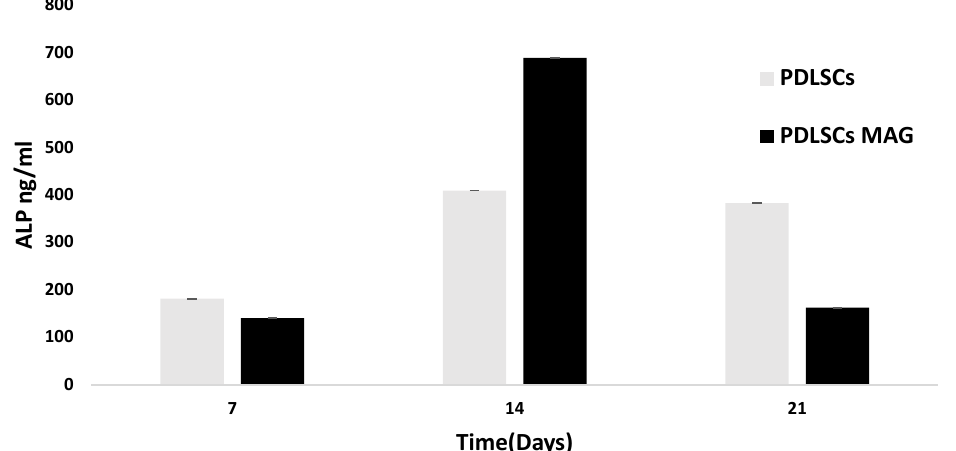
Figure 2. Alkaline phosphatase (ALP) activity for PDLSCs and PDLSCs MAG at 7,14 and 21 days after cell seeding.